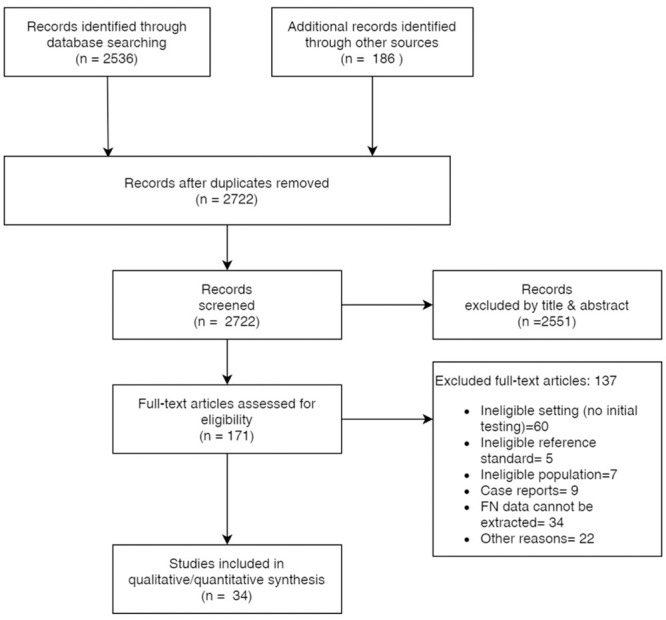
PRISMA flow diagram.